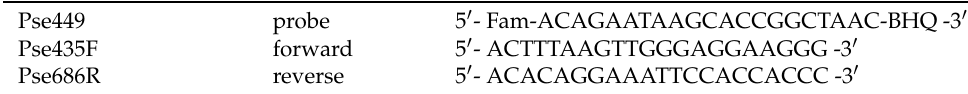
Table 2. Primers used for the identification of Pseudomonas